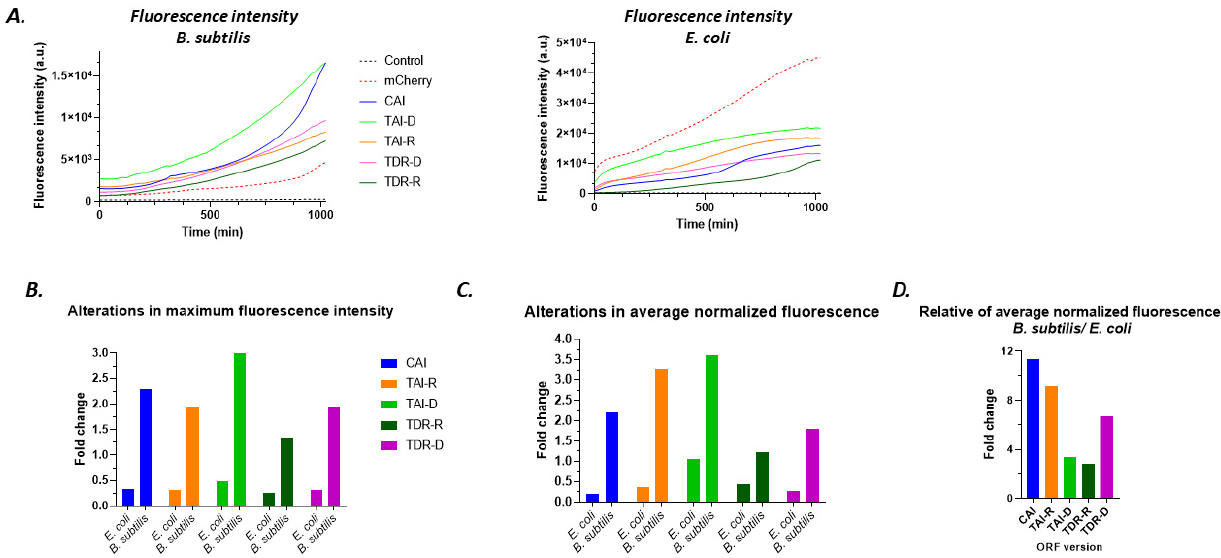
Figure 16. ( A ). Representative fluorescence intensity plots of all ORF variants in B. subtilis ( left ) and in E. coli ( right ). Note that the control lacked mCherry gene, and thus wasn’t exhibited fluorescence, and served for background subtraction; ( B ) fold change in average maximal fluorescence intensity of each ORF version relative to mCherry (unmodified version); ( C ) the same as in ( B ) but calculated for the average normalized fluorescence; and ( D ) fold of average normalized fluorescence in B. subtilis relative to E. coli .